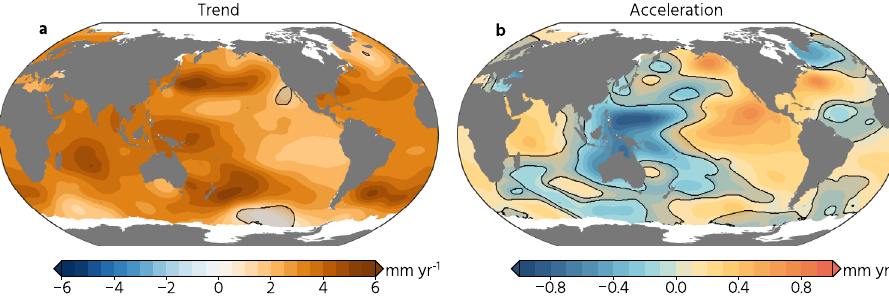
Fig. 1 Altimeter rates and acceleration. Regional rate ( a ) and acceleration ( b ) computed using the satellite altimeter data from 1993 to 2021. Gray shaded areas represent estimates that are not signi fi cant at the 95% con fi dence interval. Updated from